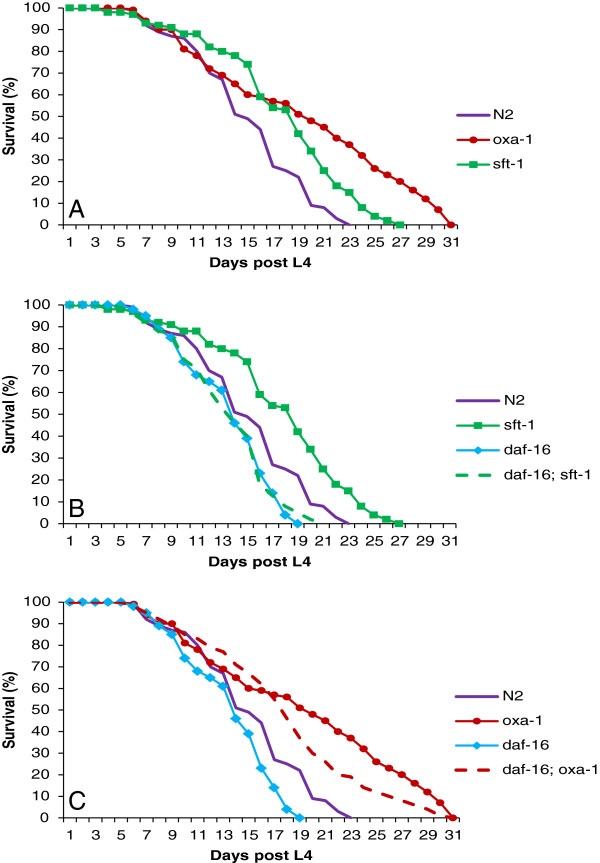
Lifespan extension in sft-1(RNAi) and oxa-1(RNAi) animals. A: Lifespan curves for N2, oxa-1(RNAi) and sft-1(RNAi) animals (recorded as number of days of survival post L4, or the time at which controls reached L4, in the case of oxa-1(RNAi) animals). Lifespan is prolonged in sft-1(RNAi) and oxa-1(RNAi) animals compared with WT controls, with oxa-1 having the greatest effect. B: Lifespan analysis of sft-1(RNAi) animals performed in a daf-16(m26) mutant background, in which sft-1 RNAi fails to extend lifespan. C: Lifespan analysis of oxa-1(RNAi) animals performed in a daf-16(m26) mutant background. oxa-1 RNAi still extends lifespan under these circumstances. The data presented combine three independent data sets (the data for individual replicate experiments can be found in Additional file 1).